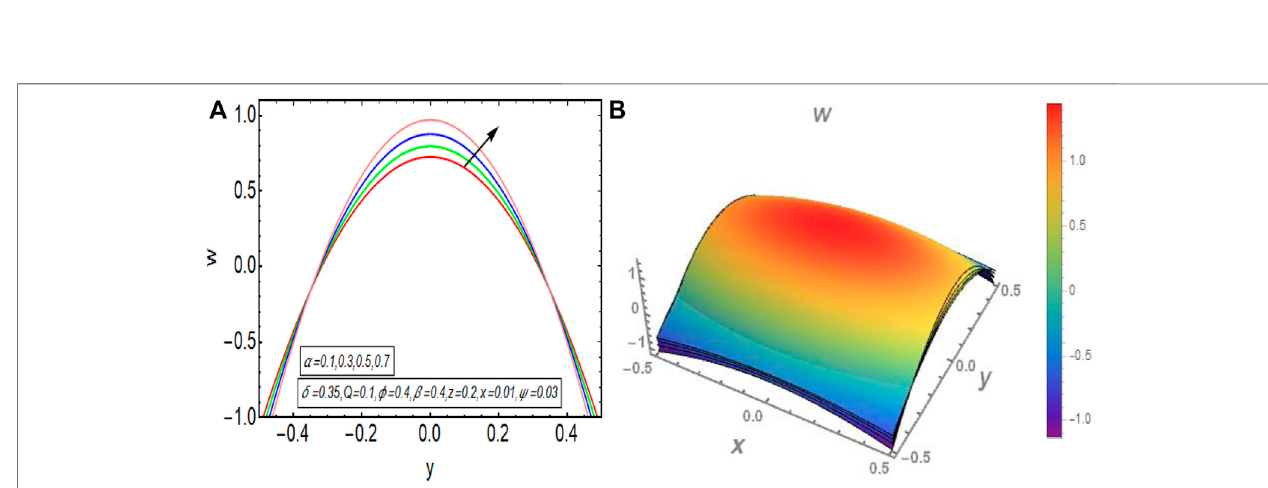
Frontiers in Physics |